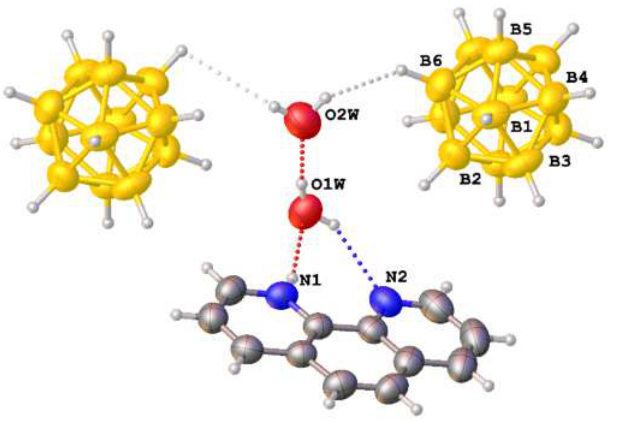
Figure 2. Fragment of the structure of 2 . 2H 2 O in representation of atoms with thermal ellipsoids (p = 50%). Only symmetrically independent boron atoms are labeled. H-bonds are depicted with dotted lines.